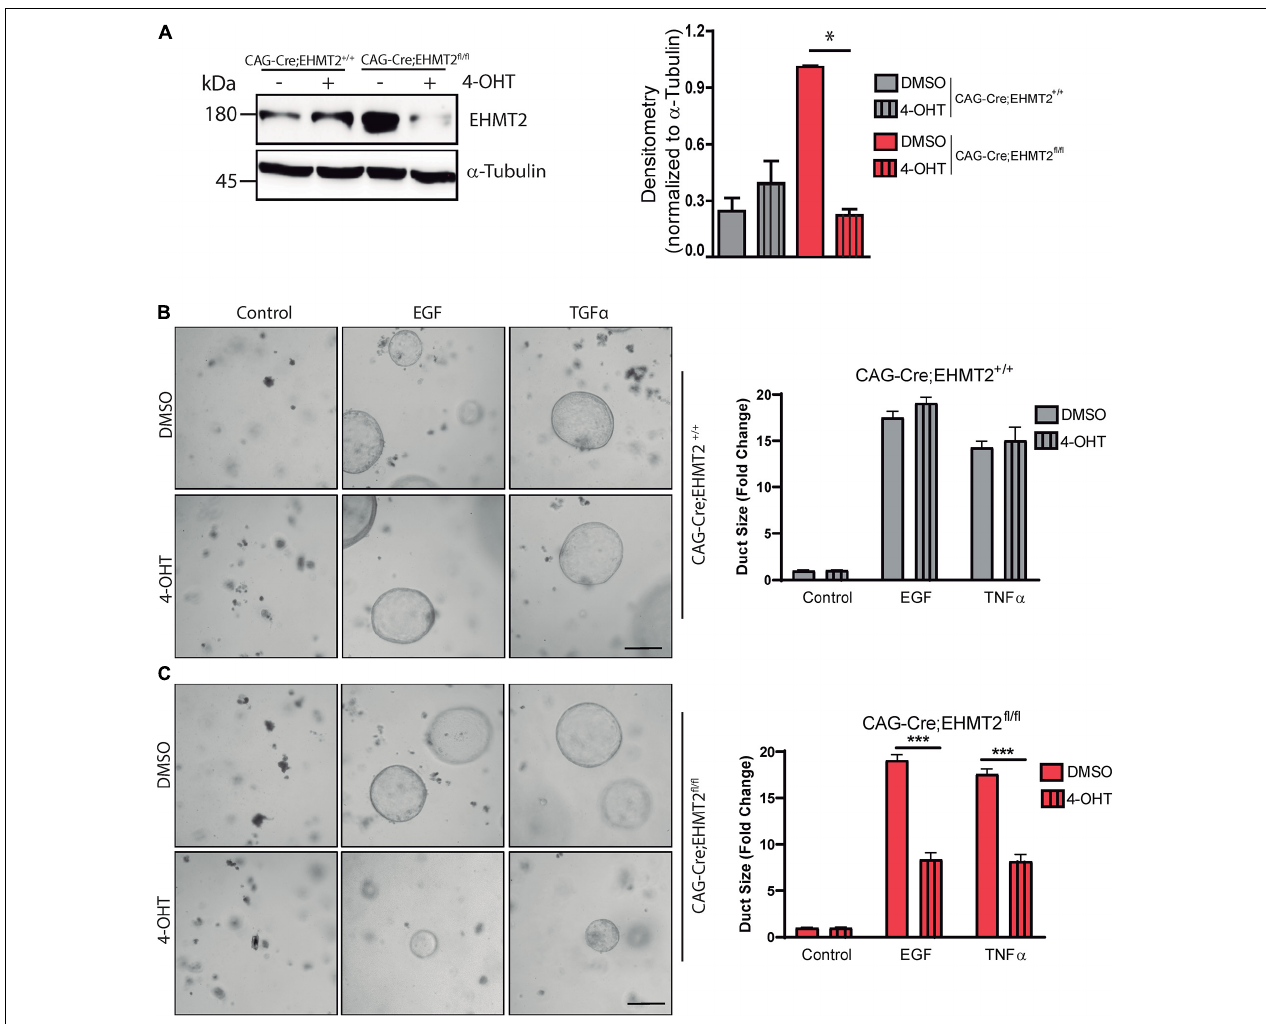
FIGURE 3 | EHMT2 inactivation impairs EGFR-KRAS-MAPK pathway-driven ADM in primary acinar cell explant cultures. (A) Acinar cell explant cultures derived from CAGGCre-ER TM ;EHMT2 + / + and CAGGCre-ER TM ;EHMT2 fl / fl animals were grown in the absence (–) or presence (+) of 4-Hydroxytamoxifen (4-OHT) to achieve EHMT2 knockout. Left: Western blot evaluation of protein lysates from acinar explant cultures was performed to confirm that 4-OHT treatment reduced EHMT2 levels in cells derived from CAGGCre-ER TM ;EHMT2 fl / fl mice. Alpha-tubulin was used as a loading control. Right: Graph depicts relative densitometry values for EHMT2 normalized to tubulin. Representative phase contrast images of CAGGCre-ER TM ;EHMT2 + / + (B) and CAGGCre-ER TM ;EHMT2 fl / fl (C) explant cultures after 5–6 days of EGF (20 ng/mL) or TGF α (50 ng/mL) exposure to induce ADM. Cells were also treated with vehicle (DMSO) or 4-OHT to inactivate EHMT2 . Right: Quantification of duct-like structures is shown as fold-change in size relative to control. * indicates p -value ≤ 0.05, and *** indicates p -value ≤ 0.001. All data is expressed as mean ± SEM (experiment performed in